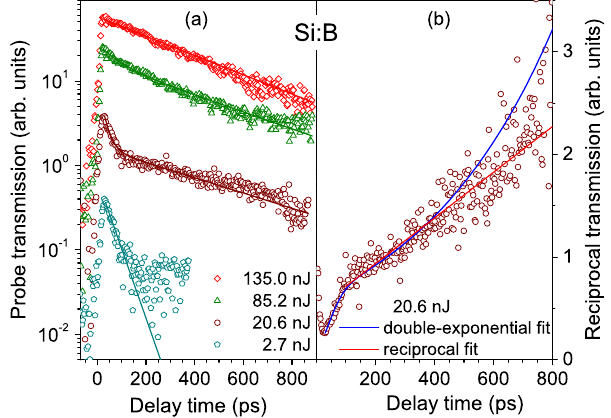
FIG. 3. Pump-probe transients for Si:B line 1. (a) The change in probe transmission induced by the pump as a function of the time delay between pump and probe pulses, observed in the Fz Si:B sample at 5 K with photon energy of 30.37 meV. The rise of the leading edge indicates the pulse duration, which was approximately 10 ps. The lowest pump pulse energy (2.7 nJ) corresponds to a focused photon fluence of (cid:7) 1 : 2 (cid:3) 10 17 photons m (cid:4) 2 . Also shown are fits using a double- exponential decay. (b) The same data as in (a) for 20.6 nJ but plotting the reciprocal of the transmission. The same fitted double-exponential decay from (a) is shown (blue line), along with a reciprocal decay fit (red line). We do not provide the parameters that determine the ordinate scale for either fit because that axis is in arbitrary units.